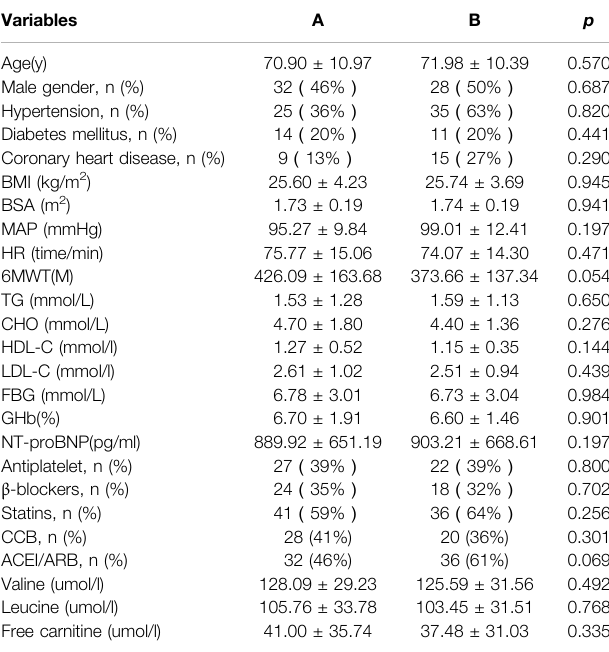
curve analysis was used for event-free survival analysis in TABLE 1 | The baseline characteristics and laboratory parameters of study